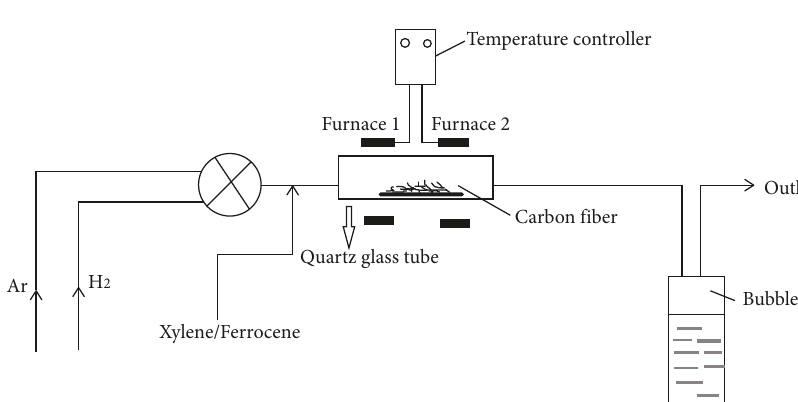
Figure 3: Schematic illustration for the development of CNT on the